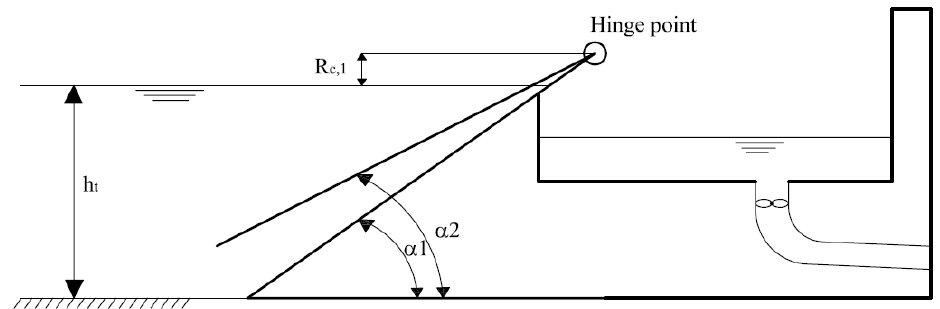
Figure 4. Scenario 2—Geometry control by adaptive slope angle